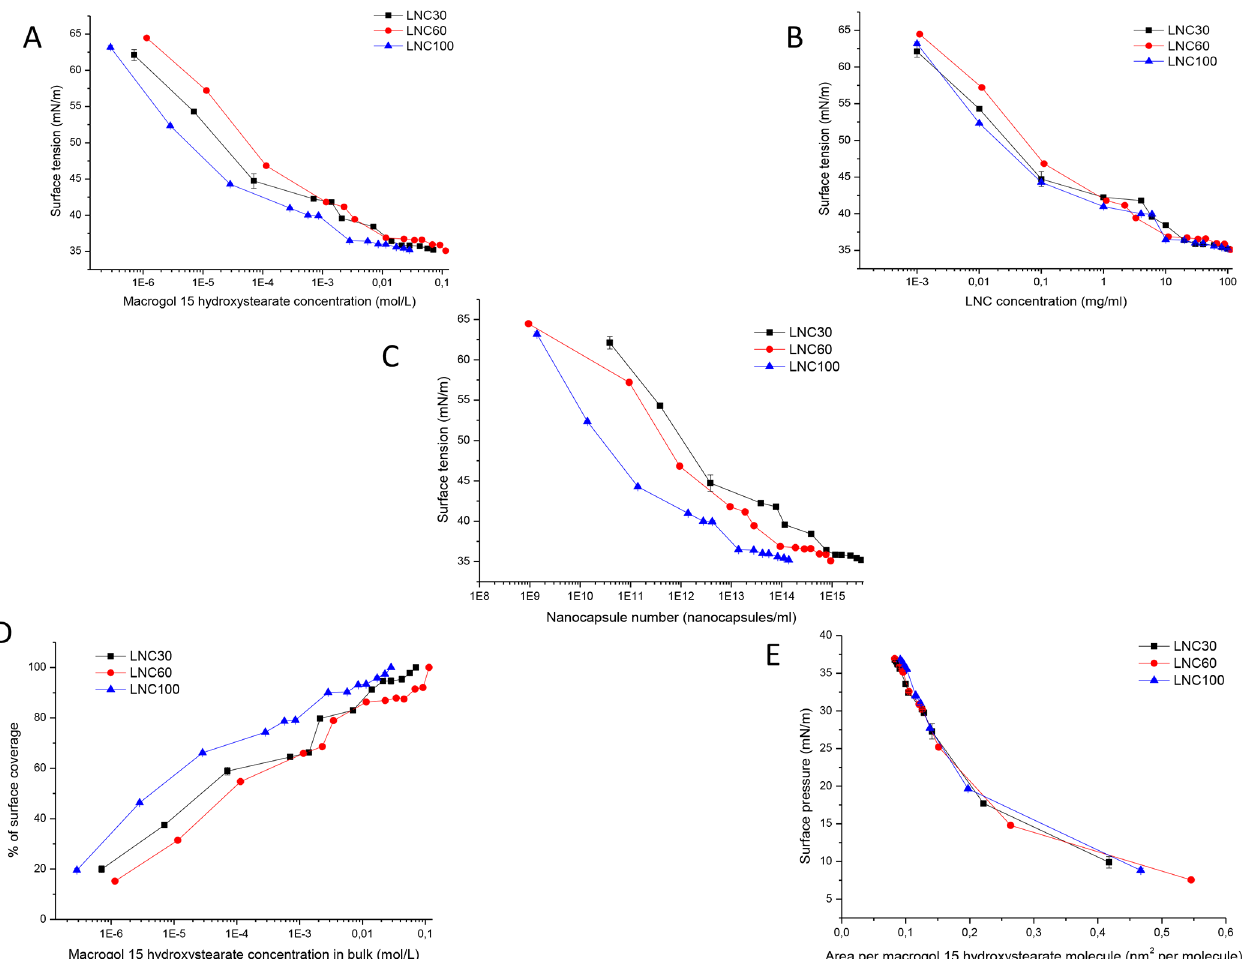
Fig 4. Surface tension as a function of MHS concentration (A) LNC concentration, (B) nanocapsule number, (C) surface coveragepercentage as a function of MHS concentration, (D) surface pressureversus area per MHS moleculeand (E) LNC formulations containing different mixing ratios of MHS/triglyceridesas determinedby the Wilhelmy plate method.